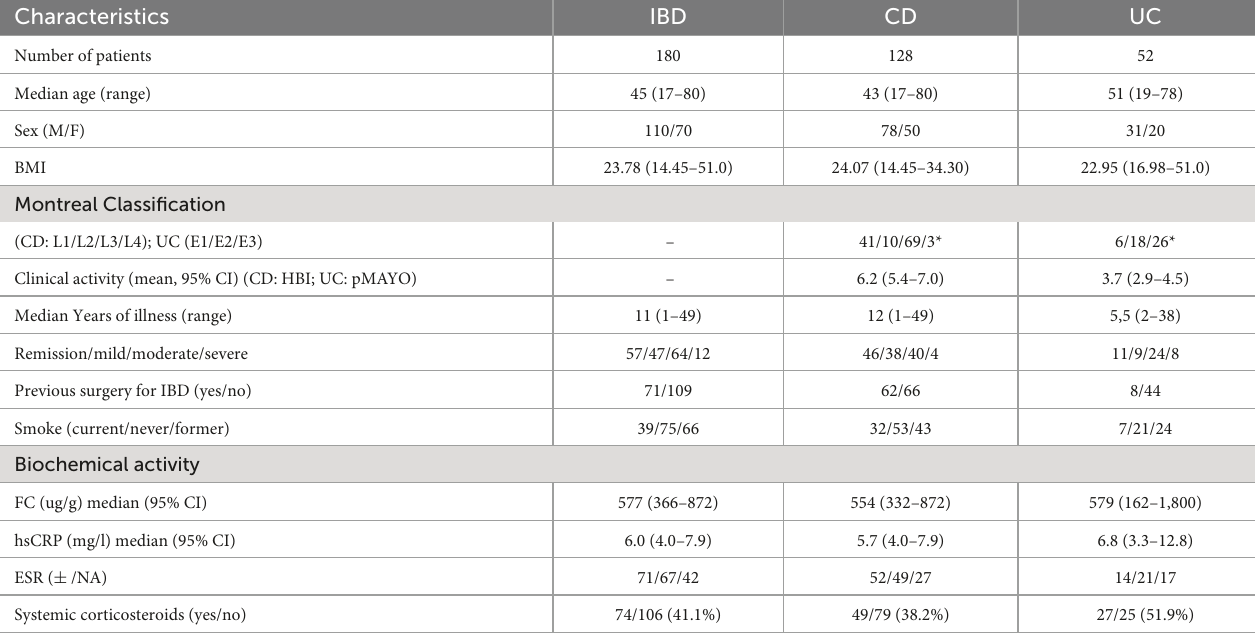
TABLE 1 Baseline clinical characteristics of the study population.